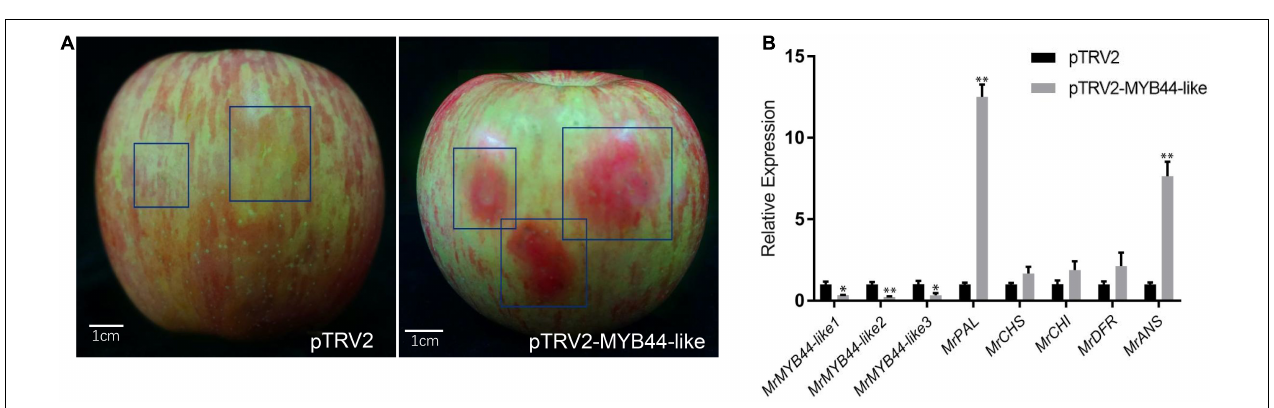
FIGURE 6 | MrMYB44-like s negatively regulate color formation in apple in viral vector-based transformation assays. (A) Malus domestica ‘Fuji’ fruit peel coloration around injection sites. Antisense MrMYB44-like (pTRV2-MrMYB44-like) was used for suppression with the TRV vector. Empty TRV2 vectors were the control. (B) Transcript levels of MrMYB44-like s and other biosynthesis genes in M . domestica ‘Fuji’ fruit peel around injection sites. Error bars represent the standard errors. ∗ P < 0.05, ∗∗ P < 0.01 using the t